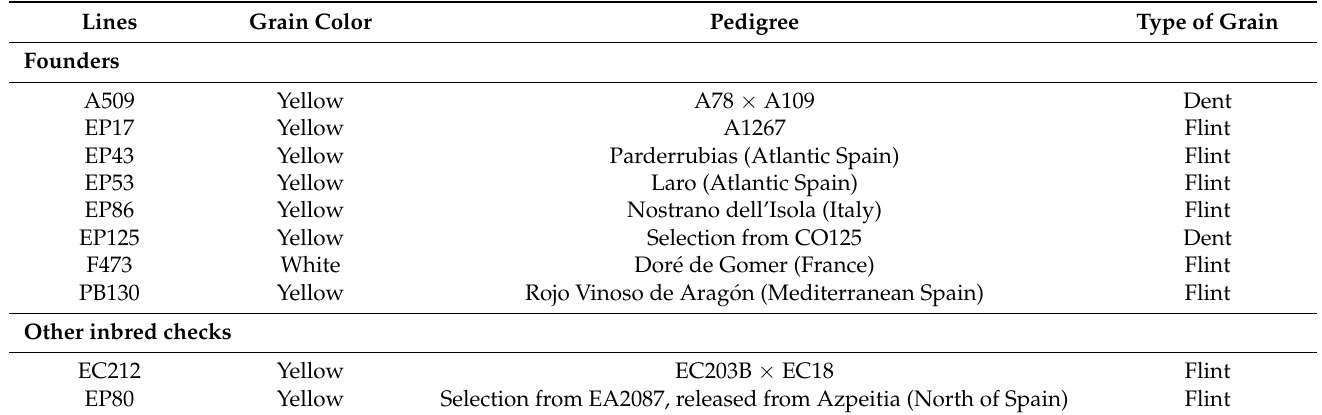
Table 1. Characteristics of the inbred founders of the MAGIC population and the checks EC212 and EP80.